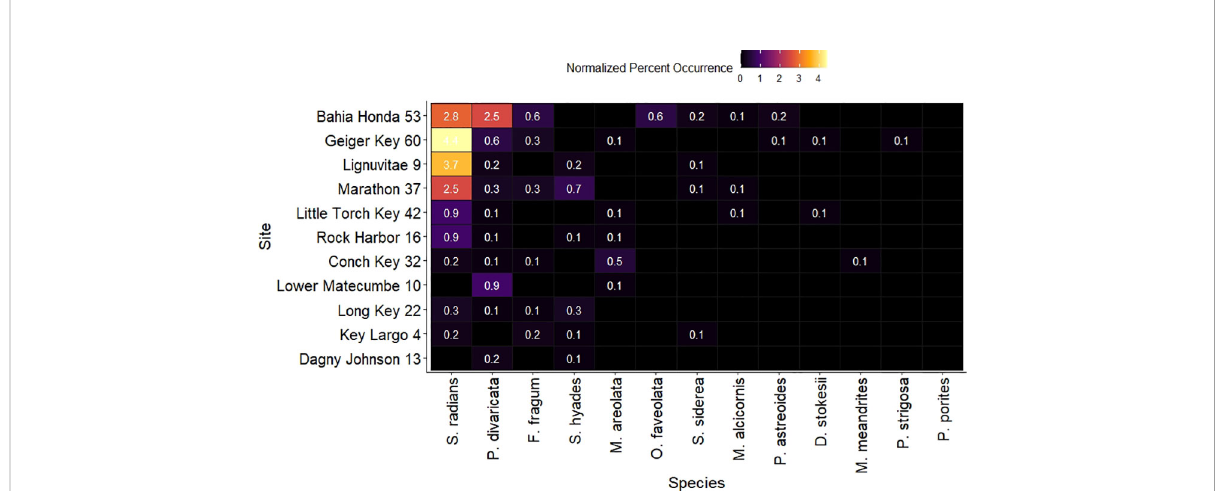
FIGURE 5 Heatmap depicting hard coral normalized percent occurrence for all species present within each study site. Percent occurrences lower than 0.1% for species within certain sites were excluded from the graph. Site names are shown on the y axis and species names on the x axis. Both sites and species are ordered from highest to lowest mean percent